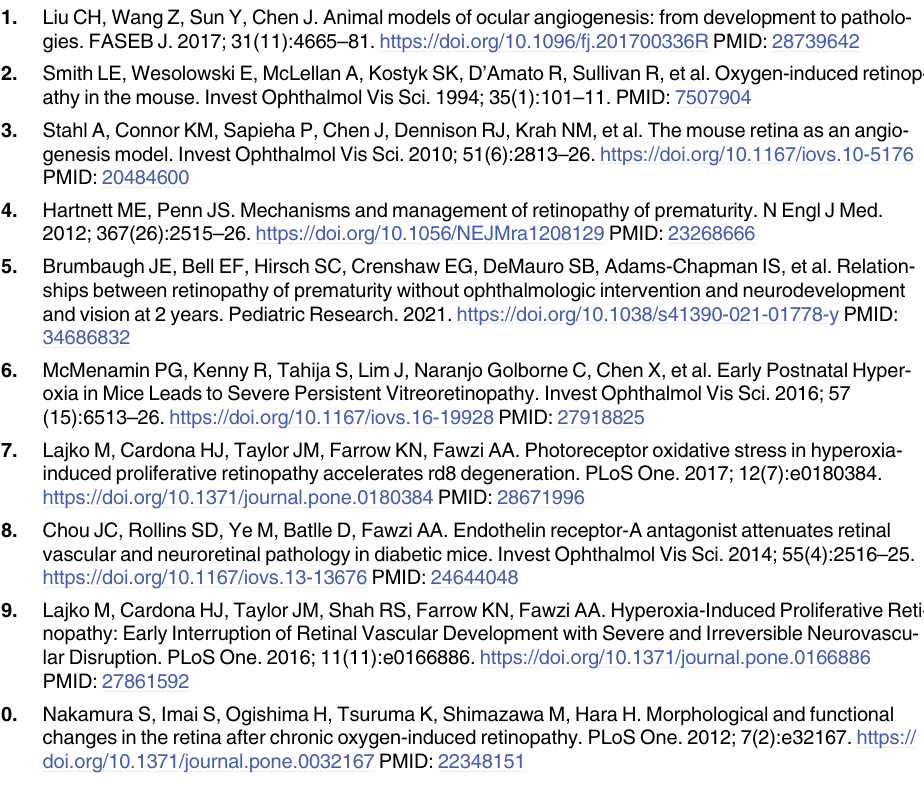
S1 Fig. Normal outer segments of the photoreceptors seen in L-HIPR. Immunolabeled par- affin cross-sections labeled with anti-Rhodopsin (green) and nuclei with DAPI (blue) over- layed with differential interference contrast microscopy. Scale bars equal 50 μ m. (TIF) S2 Fig. Representative normal images for room air eyes. (A) IB4-488 cardiac perfusion (B) α -SMA and (C) Masson Trichrome staining. Scale bars equal 300 μ m in (A) and (B), 50 μ m in (C).